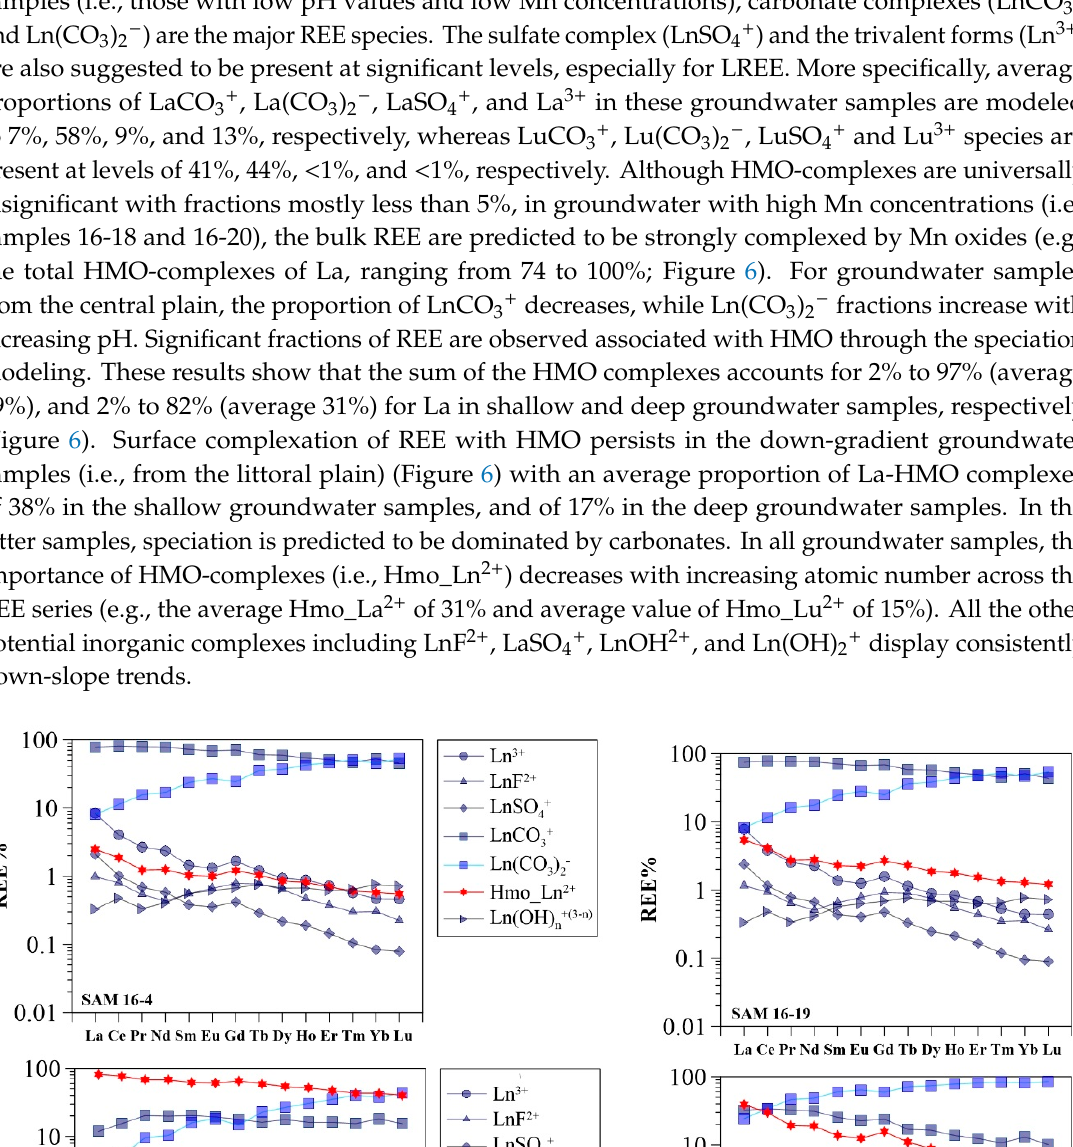
Figure 6. Speciation of groundwater La and its proportion of binding with hydrous manganese oxyhydroxides (HMO) as a function of distance from the charge area.